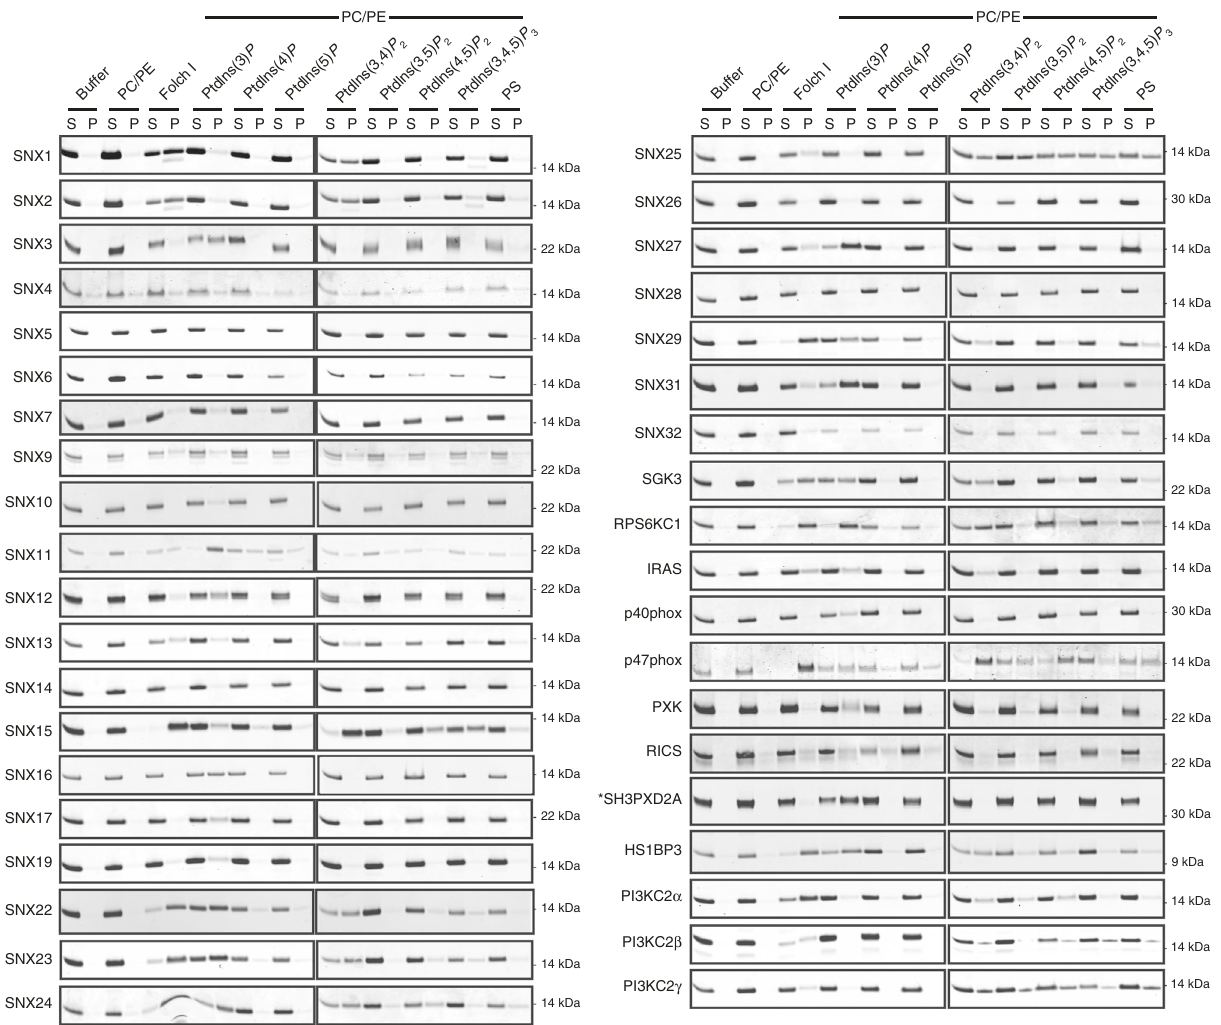
Fig. 1 Membrane binding of the human PX domains by liposome pelleting assay. Bacterially expressed and puri fi ed PX domains with GST tags removed were incubated with arti fi cial liposomes as indicated. Liposomes included POPC/POPE (PC/PE) as a negative control, Folch I as an indicator of broad membrane-binding activity, or PC/PE liposomes containing the speci fi c lipids PtdIns3 P , PtdIns4 P , PtdIns5 P , PtdIns(3,4) P 2 , PtdIns(3,5) P 2 , PtdIns(4,5) P 2 , PtdIns(3,4,5) P 2 , or PS. Samples were subjected to ultracentrifugation followed by SDS-PAGE and Coomassie staining of the unbound supernatant ( S ) and bound pellet ( P ) fractions. Gel fi ltration pro fi les of the puri fi ed proteins are shown in Supplementary Figure 1. SH3PXD2A (indicated by *) is the only protein that has its GST-tag